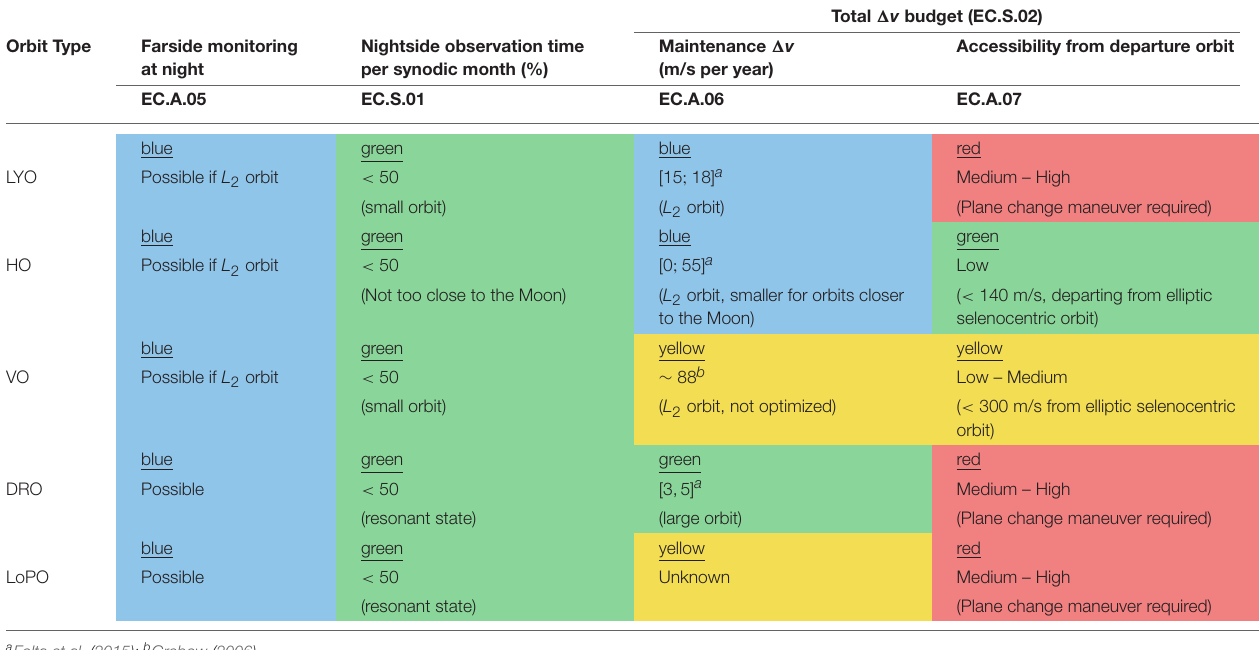
TABLE 6 | Trade-off of CRTBP